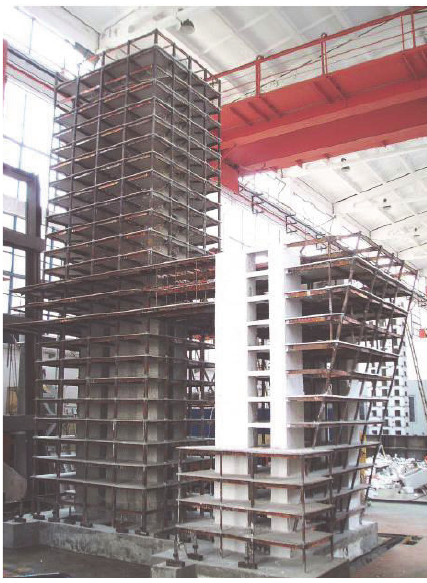
Figure 1: Model of shake table testing.